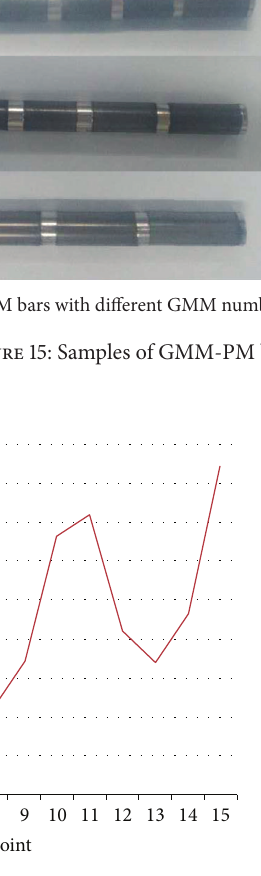
Figure 16: Magnetic field intensity test result.